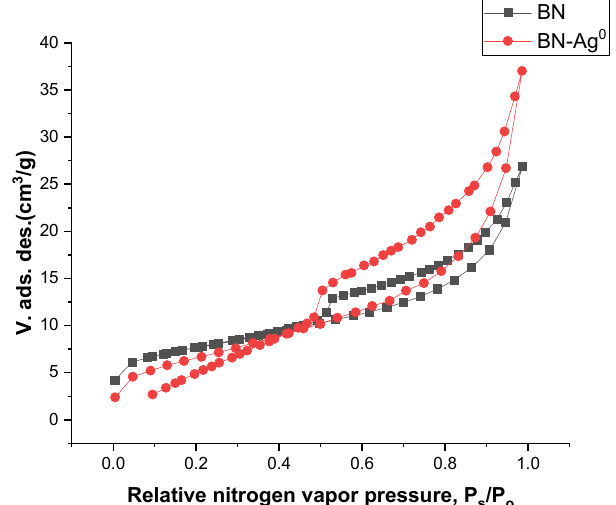
Figure 4. Adsorption–desorption isotherms of BN and BN-Ag 0 . The specific surface areas of the natural clay and of chemically modified clay BN-Ag 0 are presented in Table 1. By chemical modification, the specific surface area of the clay decreases from 25.80 m 2 /g to 24.29 m 2 /g according to Table 2. Table 2. Textural results of BN and BN-Ag 0